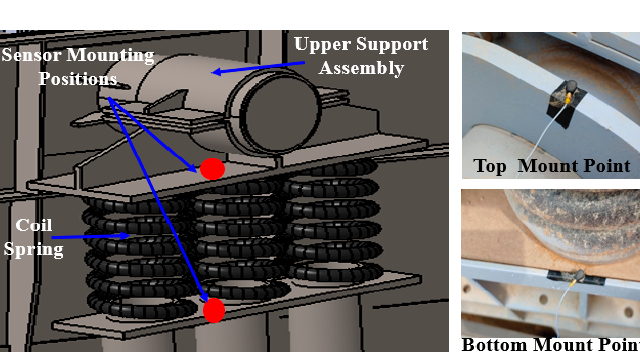
Figure 5. Vibration measurement points of the screen and sand units.